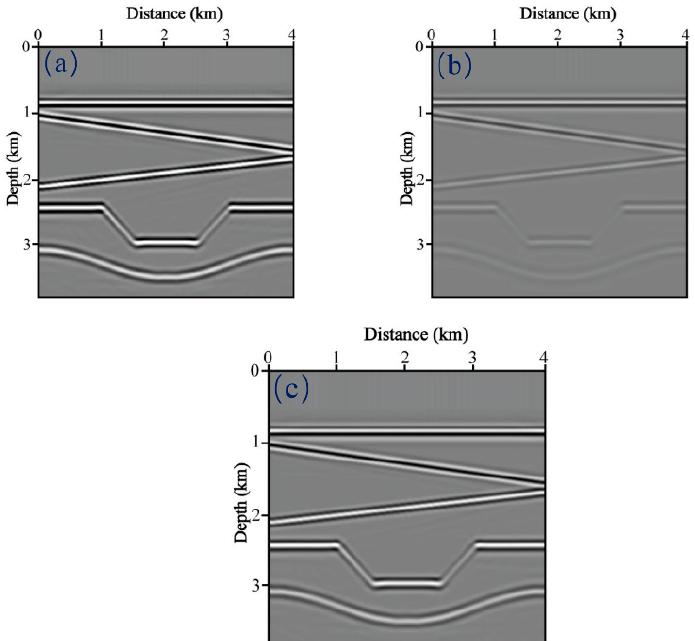
Figure 4. PP − images of the Sag model obtained by ( a ) the conventional ERTM from lossless seismic data, ( b ) attenuated seismic data without compensation, ( c ) attenuated seismic data with the proposed Q -ERTM scheme.